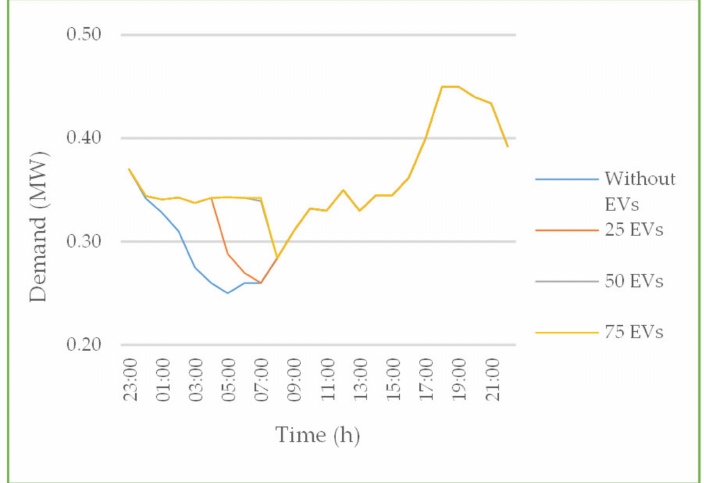
Figure 5. The effect of charging on LC1 when N = 25, 50 and 75 cars are used for valley filling between 23:00 and 07:00.